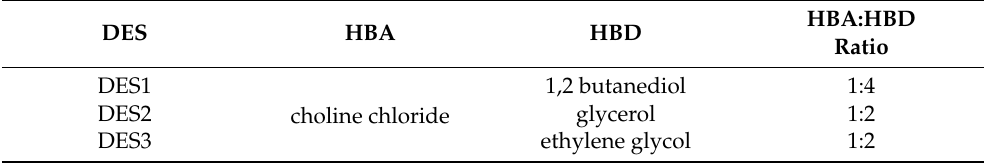
Table 7. Synthesized DESs and their